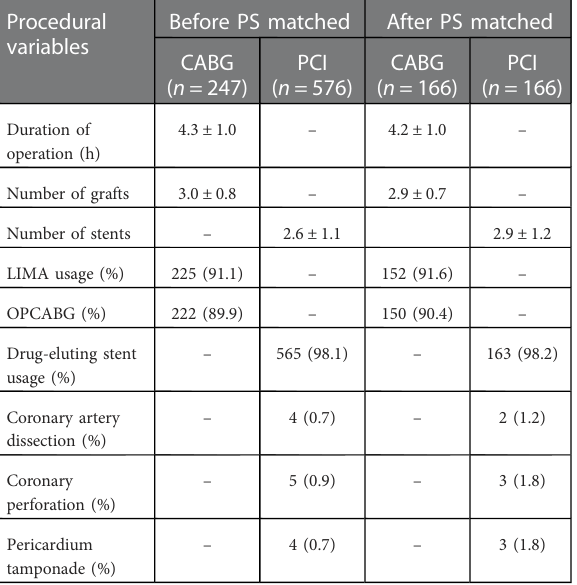
TABLE 2 Comparison of perioperative data between CABG and PCI groups.